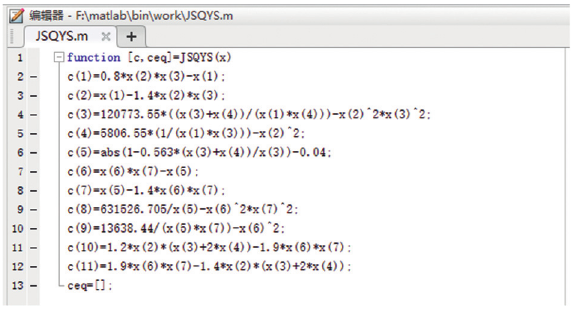
Figure 5: M files for constraints.